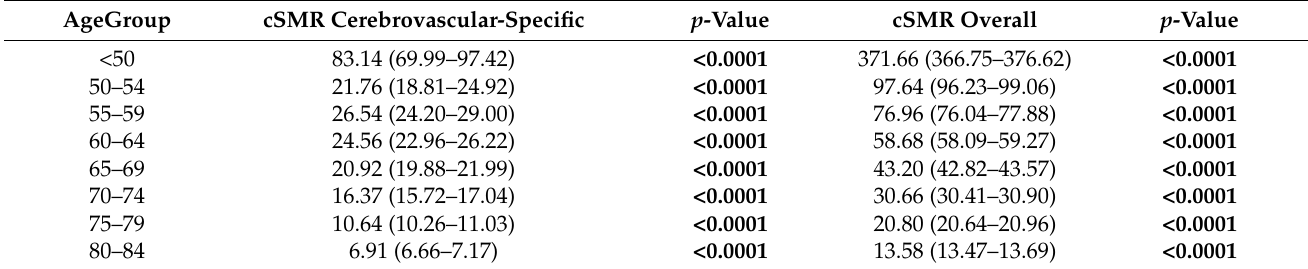
Table 2. Age-specific and overall standardized mortality ratios for the years 1999–2015 among colorectal cancer patients relative to the U.S. standard population.